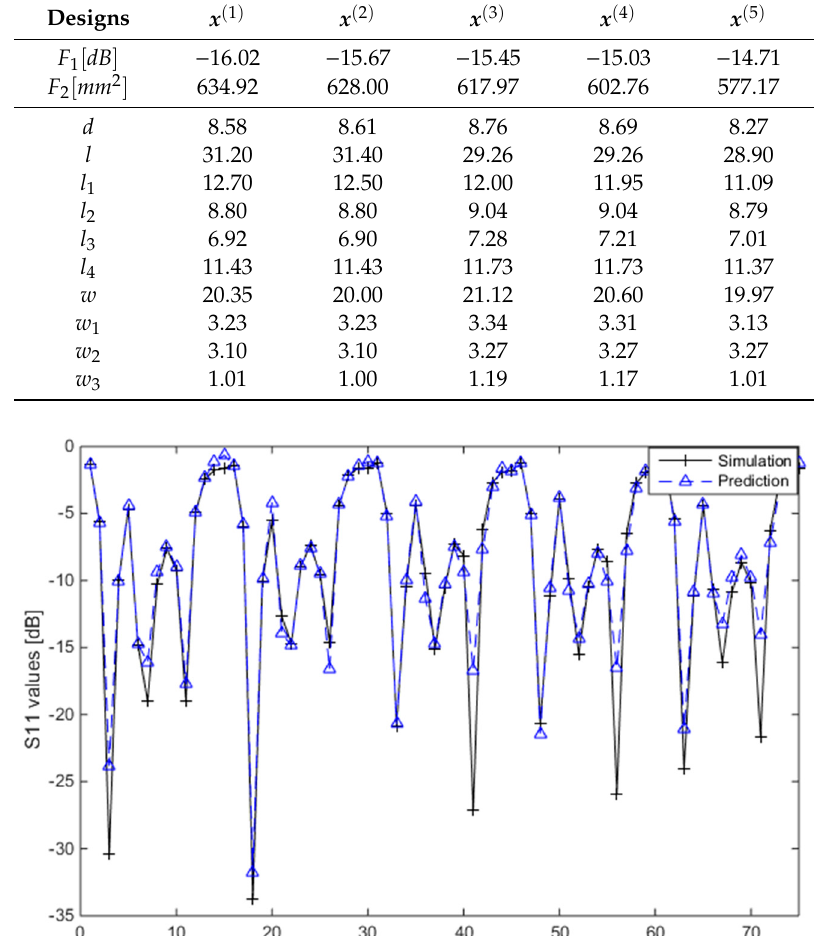
Table 3. Miniaturized multiband planar antenna: selected Pareto-optimal designs.